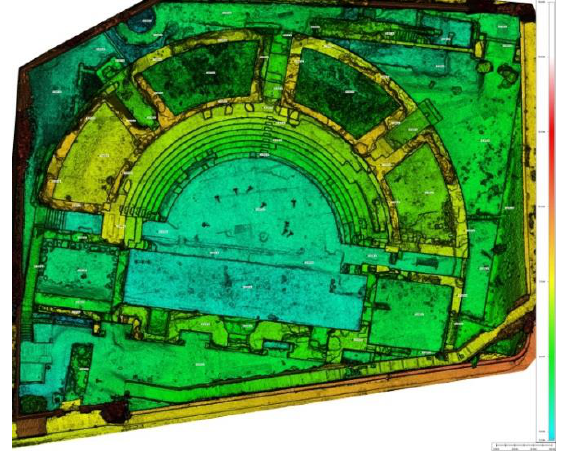
Figure 6. The 2.5D DEM derived from the UAV